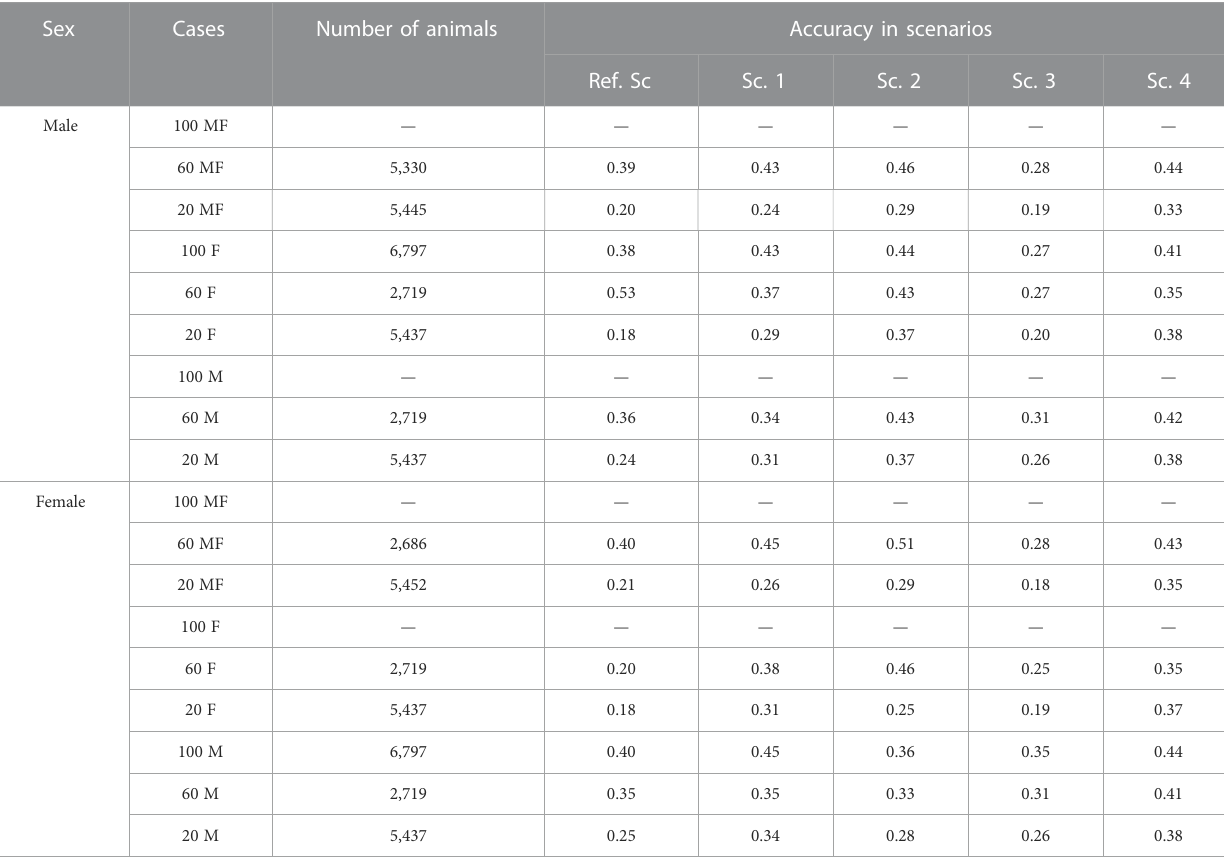
TABLE 4 Prediction accuracy for animals without phenotypic records in males and females according to